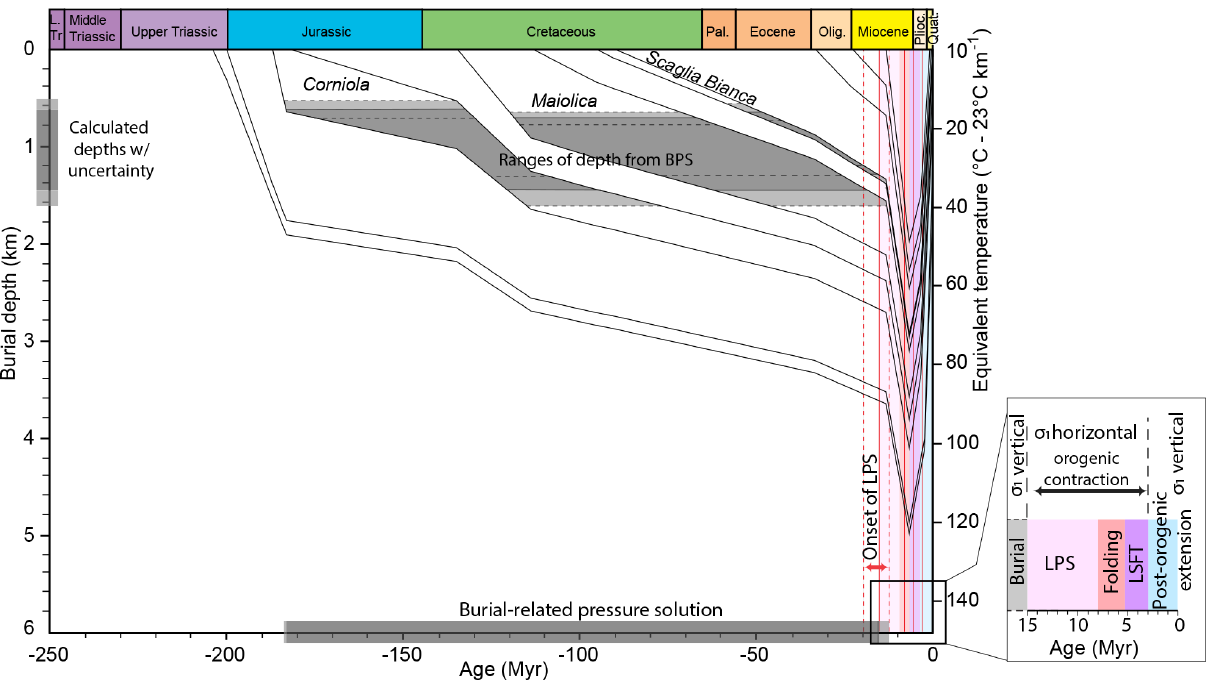
Figure 10. Burial model constructed considering thickness from well data (central UMAR) corrected from both chemical and physical compaction. The range of depths reconstructed from bedding-parallel stylolite roughness inversion (with uncertainty) are reported for each formation as grey shades. The derived corresponding timing and depth of active dissolution are reported on the x axis and left y axis, respectively. The timing of the deformation is reported on the righthand side in the inset. The onset of layer-parallel shortening is deduced from the latest bedding-parallel stylolite to have been active; the effect of the 12% uncertainty is represented by dashed red lines; the onset of late-stage fold tightening is given by U–Pb dating of fault coating in this study. The timing of folding and post-orogenic extension are reported from published sedimentary data (see text for more detailed explanations). LPS stands for layer-parallel shortening and LSFT for late-stage fold